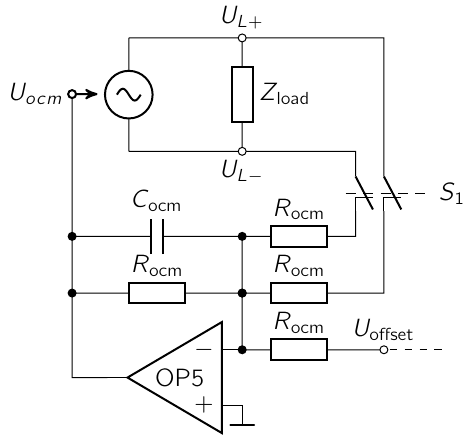
Figure 5: The active offset compensation circuit sums up U U U L+ , L- and an adjustable offset . The common-mode signal is fed back over a 1st order low pass filter to the U ocm input of the source.